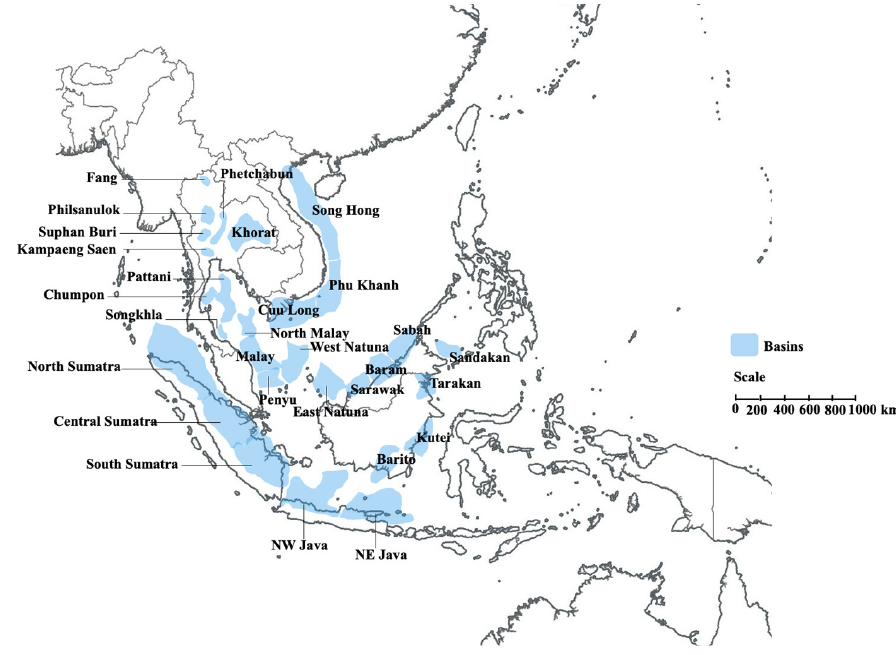
Figure 22. Major sedimentary basins in ASEAN .